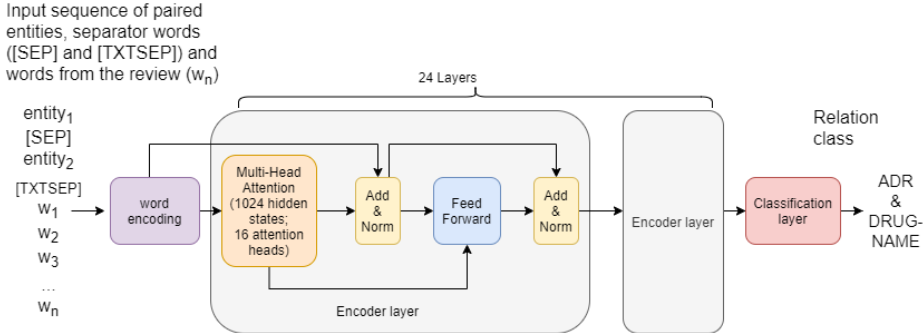
Figure 2. Conceptual scheme of our approach to relation extraction based on a language